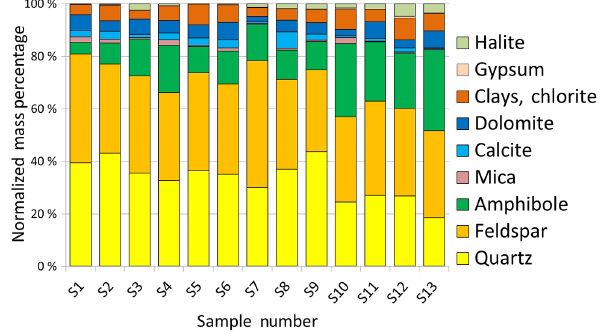
Figure 3. Normalized mineral compositions by percentage of mass of 13 sieved soil samples < 38µm collected at four localities along the Red Sea coastal area, as measured by